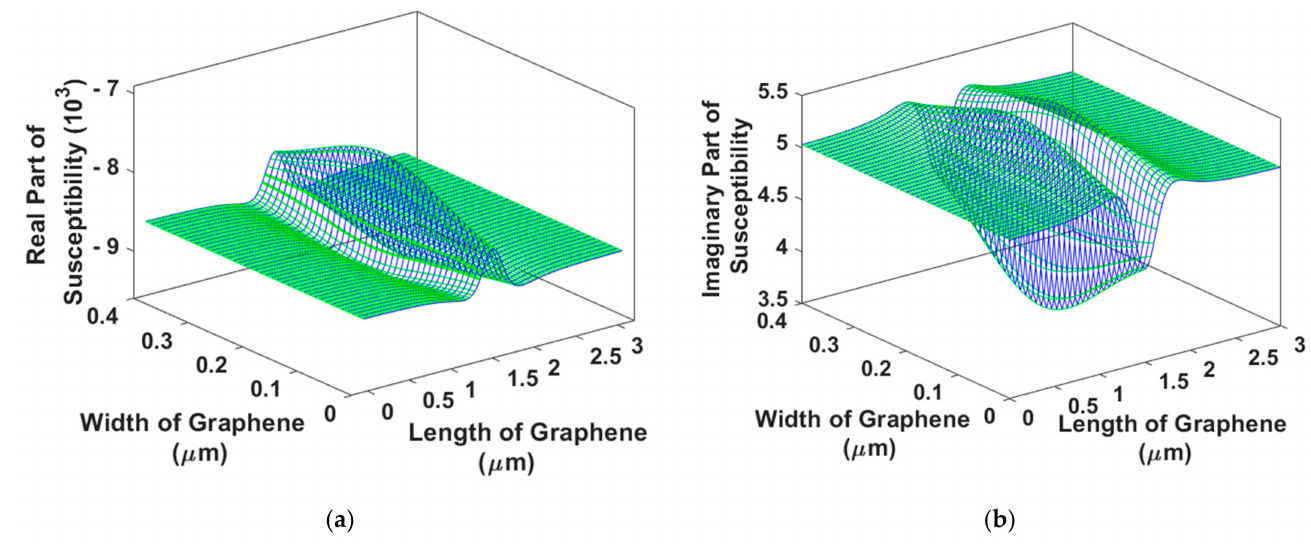
Figure 6. ( a ) Real and ( b ) imaginary parts of susceptibility for a chemical potential of